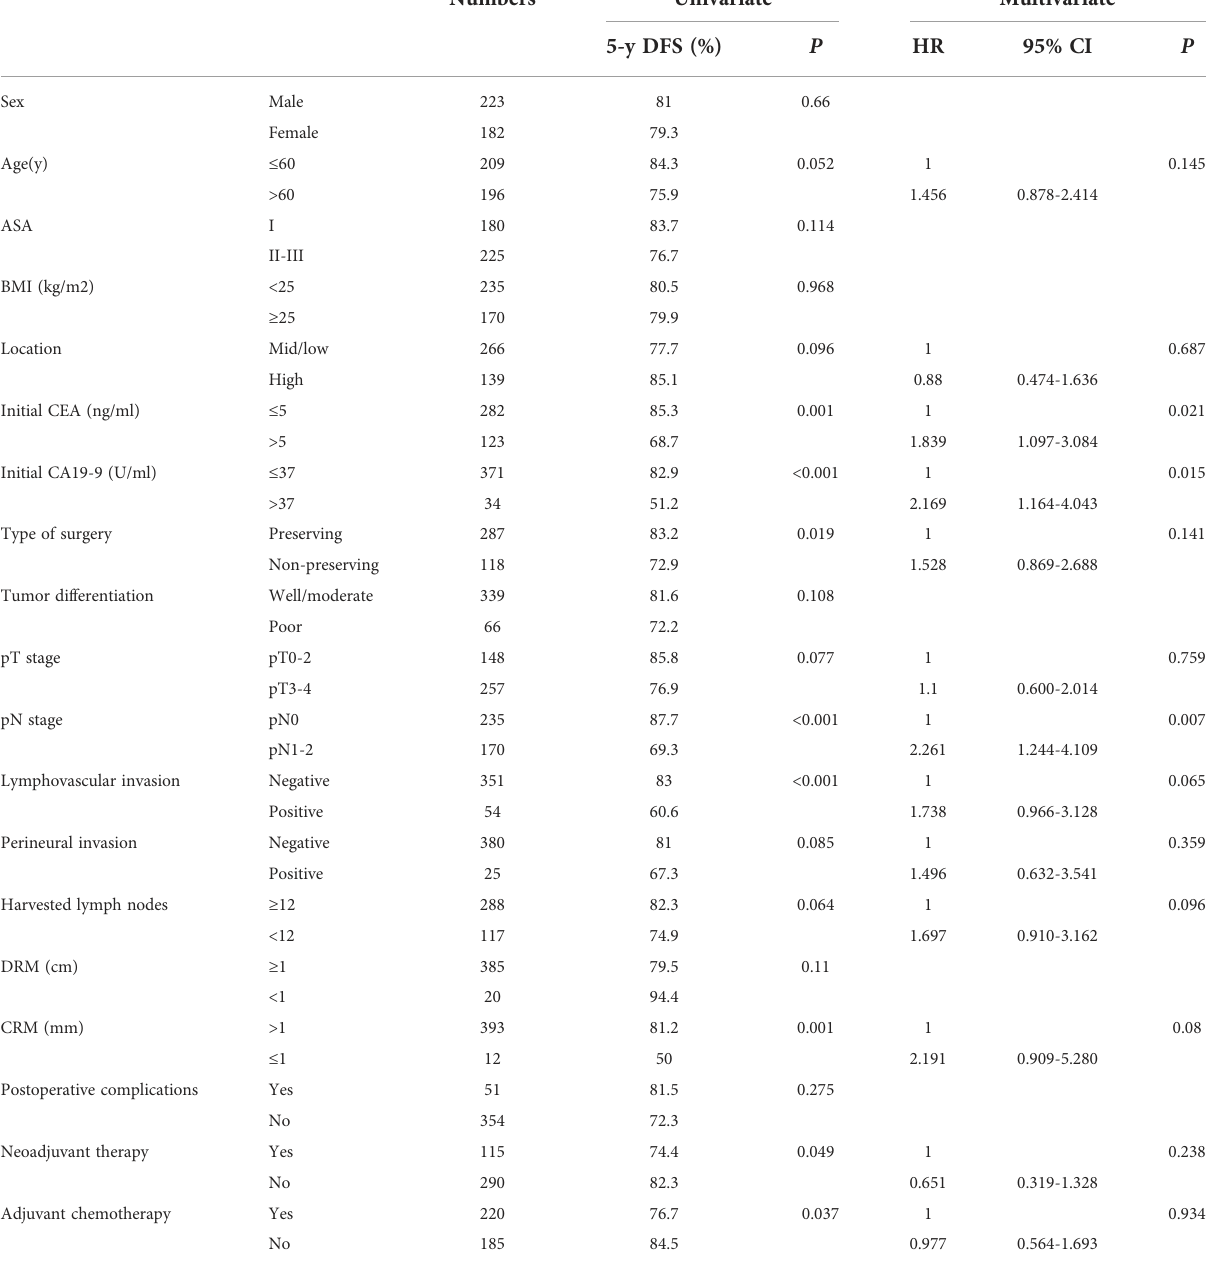
TABLE 5 Univariate and multivariate analyses of prognostic factors for disease-free survival (DFS). Numbers Univariate